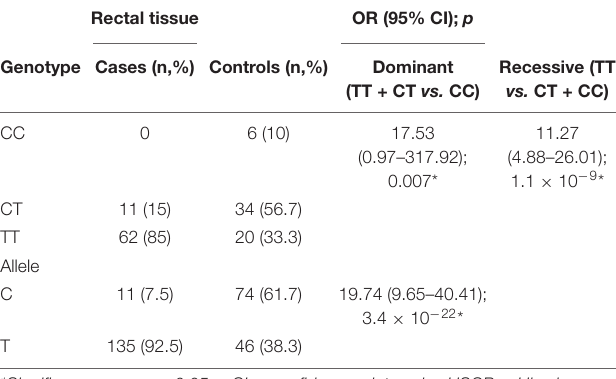
TABLE 2 | Association between RET rs2435357 and risk of HSCR in our study. Rectal tissue